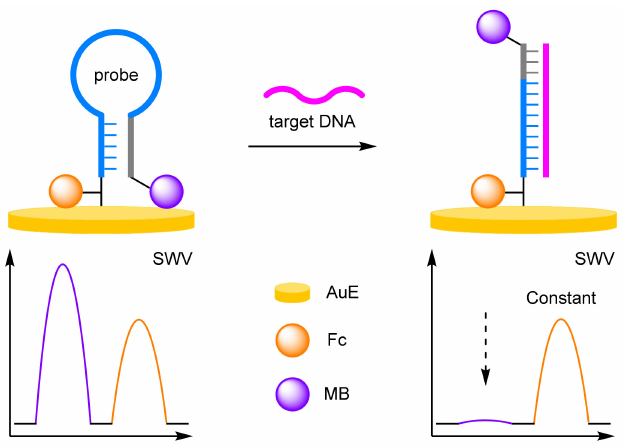
Figure 2. Schematic representation of a biosensor for target DNA